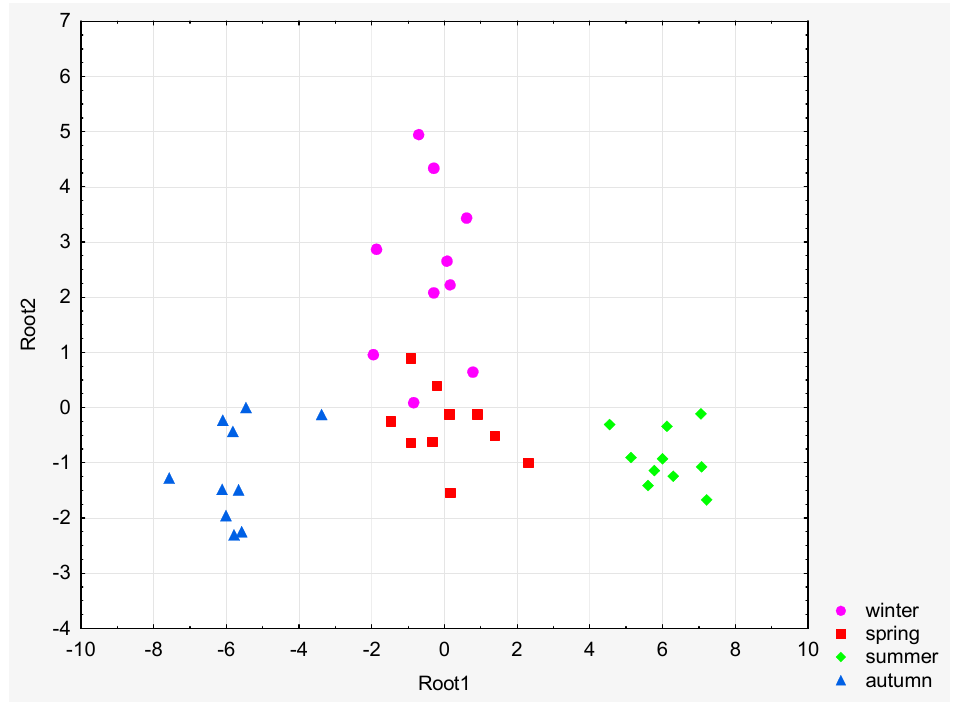
Figure 4. Results of the discriminant analysis (DA) for sample collection seasons.